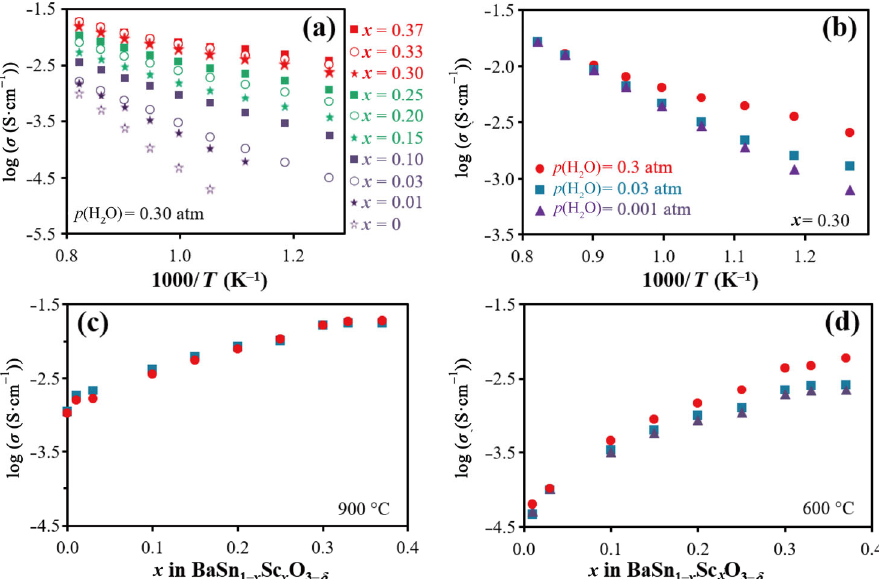
Fig. 3 Total σ of the BaSn 1 − x Sc x O 3 − δ ceramic samples: (a) temperature dependency at p (H 2 O) = 0.30 atm, (b) temperature dependencies for BaSn 0.7 Sc 0.3 O 3 − δ at different humidification levels; concentration dependencies of the total σ depending on p (H 2 O) at (c) 900 ℃ and (d) 600 ℃